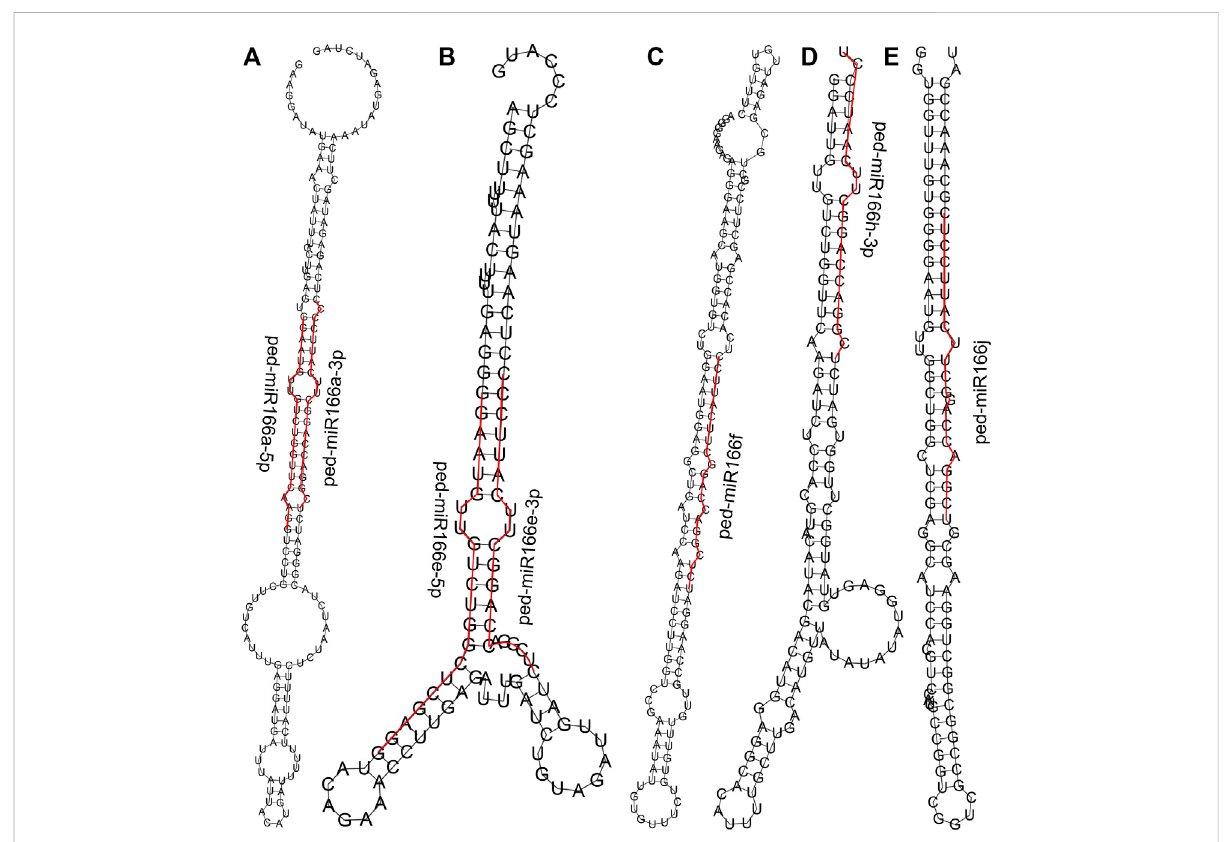
FIGURE 2 Predicted secondary structures of seven members of the miR166 family. Sequences of mature miR166s are denoted by the red line. Secondary structures predicted for ped-miR166a-3p and ped-miR166a-5p (A) , ped-miR166e-3pand ped-miR166e-5p (B) , ped-miR166f (C) ,ped-miR166h-3p (D) , and ped-miR166j (E)